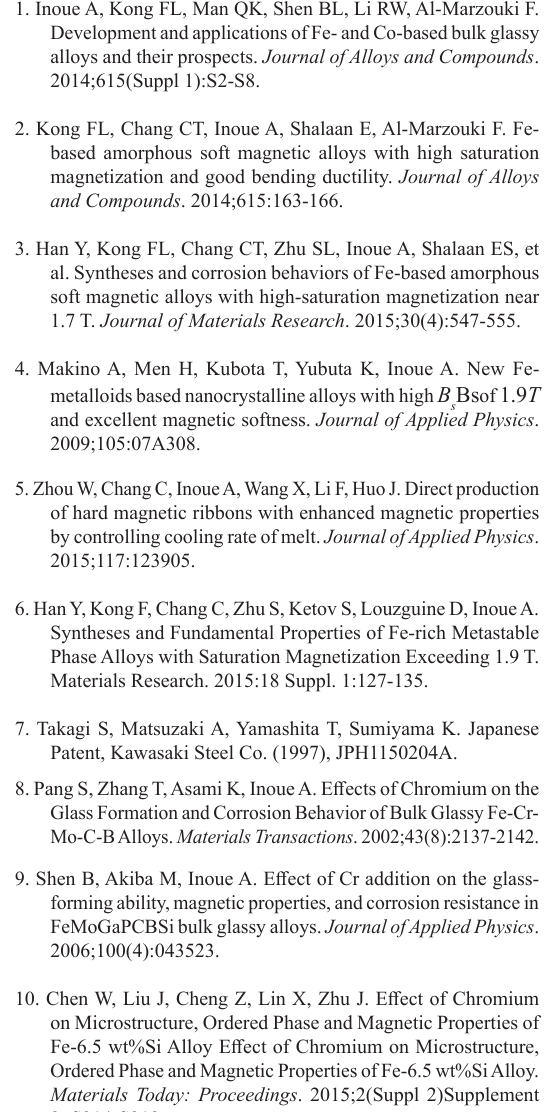
Figure 5: Polarization curves of the Fe x=1, 2) ribbon alloys in 3.5mass% NaCl solution at 298K. The ribbons were annealed at 823 K for 600s.